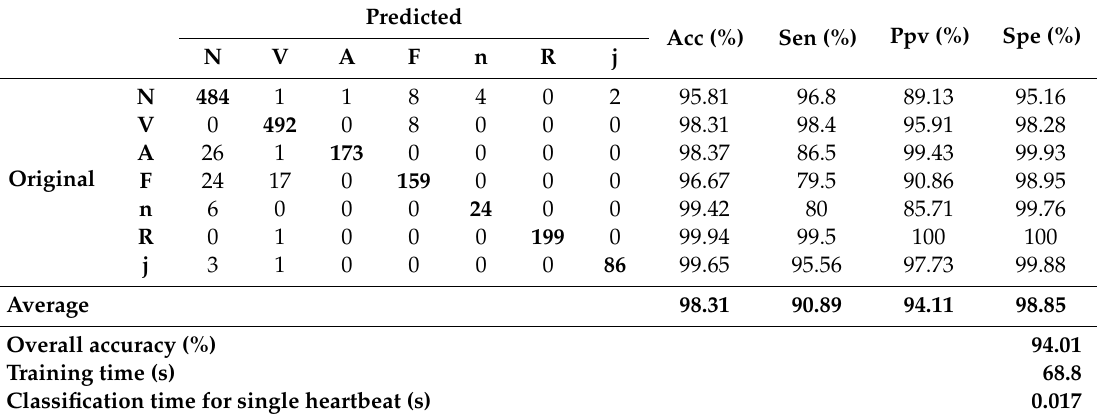
Table 11. Confusion matrix obtained using II and V1 leads across 5 folds.